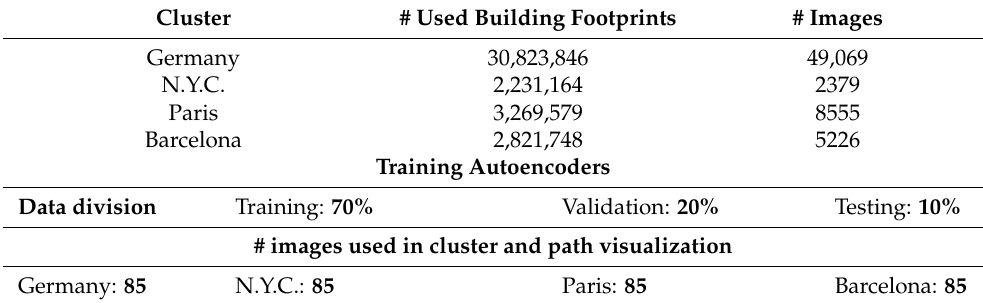
Table 1. Experiment data